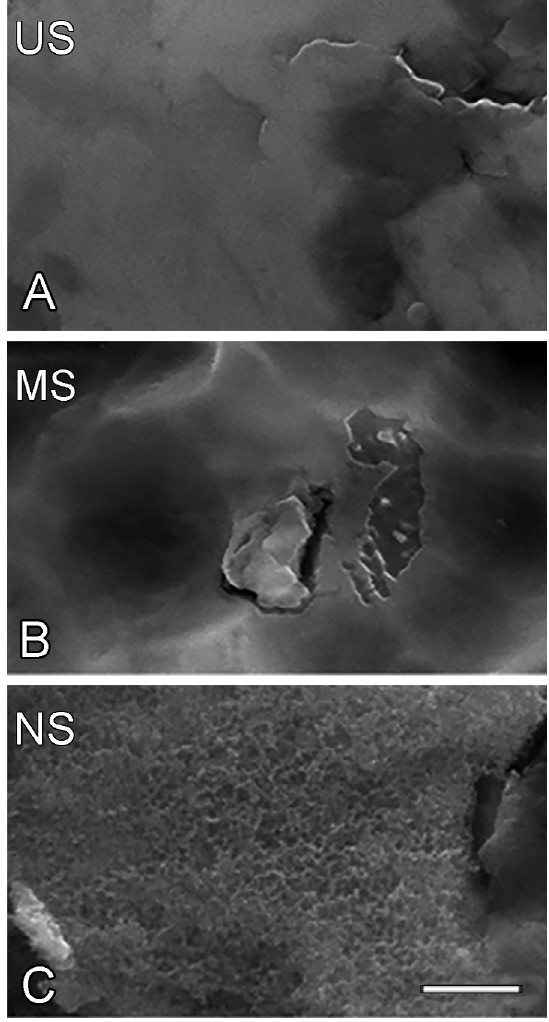
Figure 3- High-resolution scanning electron micrographs of US (A), MS (B), and NS (C). Scale bar: 500 nm